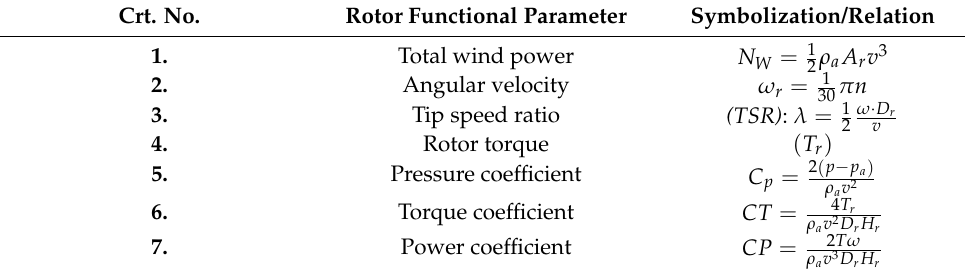
Table 2. Functional parameters for vertical-axis wind turbine rotors [61–65]. Crt.